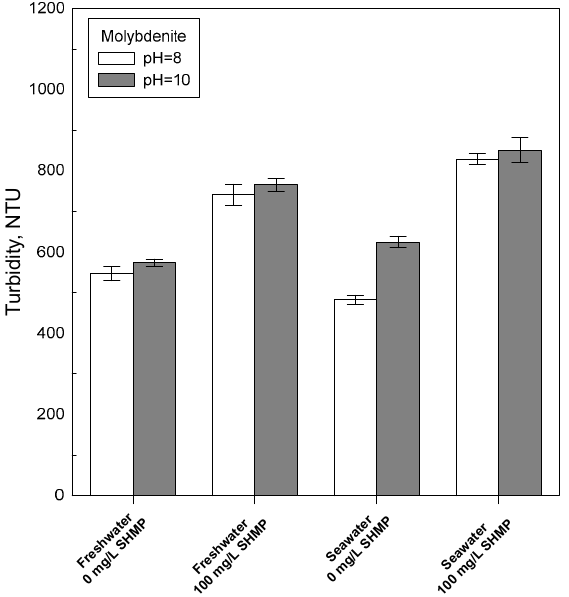
Figure 5. Turbidity results of molybdenite suspensions at pH 8 and 10, in freshwater and seawater, with and without SHMP as a dispersant.